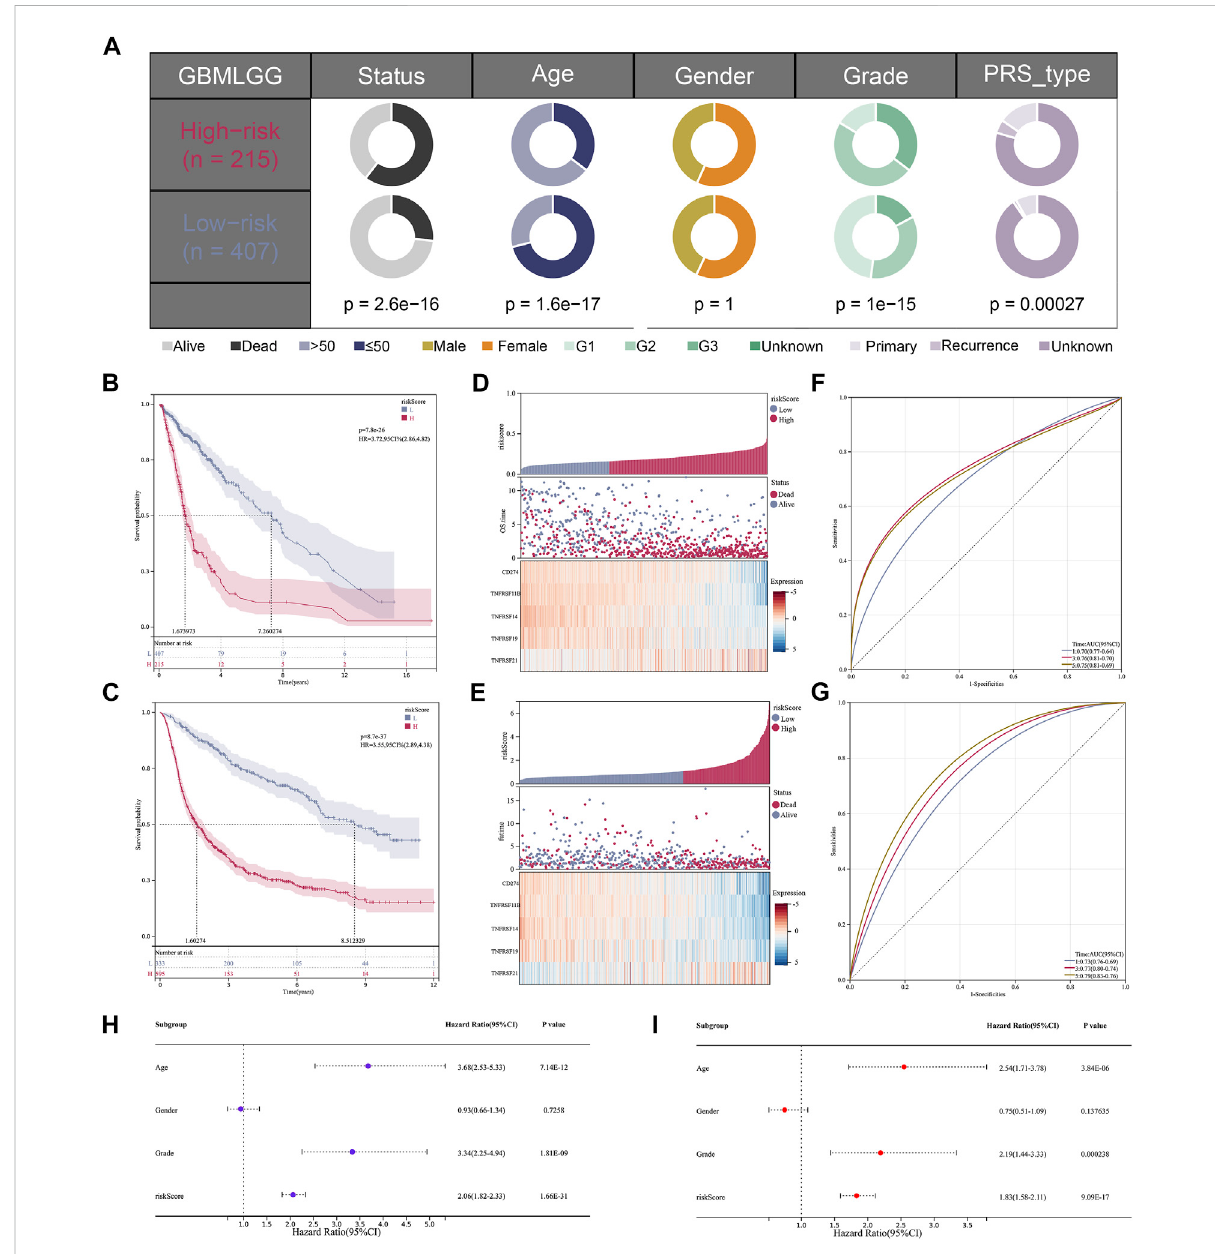
FIGURE 4 The validation of the model based on costimulatory molecules. (A) Clinical correlation analysis of the model. (B,C) KM survival curve analysis of the model [ (B) ; HR = 3.72, p = 7.8e-26] [ (C) ; HR = 3.55, p = 8.7e-37]. (D,E) The risk graph shows that the mortality rate of patients increases gradually as their risk valueincreases. (F,G) 1,3, and 5 years ROC curveanalysisof the model. (H,I) Univariateand multivariate independent prognostic analysis for the